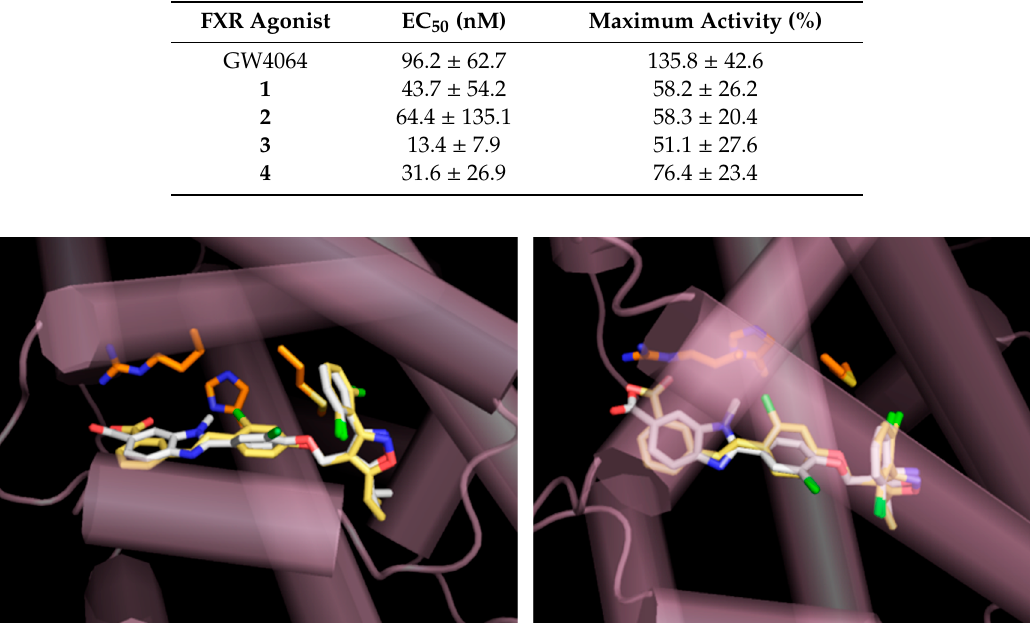
Figure 1. Modeling of FXR complexed with GW4064 and novel synthesized FXR agonist 3 . A complex-model of human FXR α -LBD monomer (PDB ID: 3DCT, purple cylinders and orange sticks) with GW4064 (X-ray; yellow sticks) and novel FXR agonist 3 (model; white sticks) was built using AutoDock Vina1.1.2. Left panel: view from the side. Right panel: view from above.